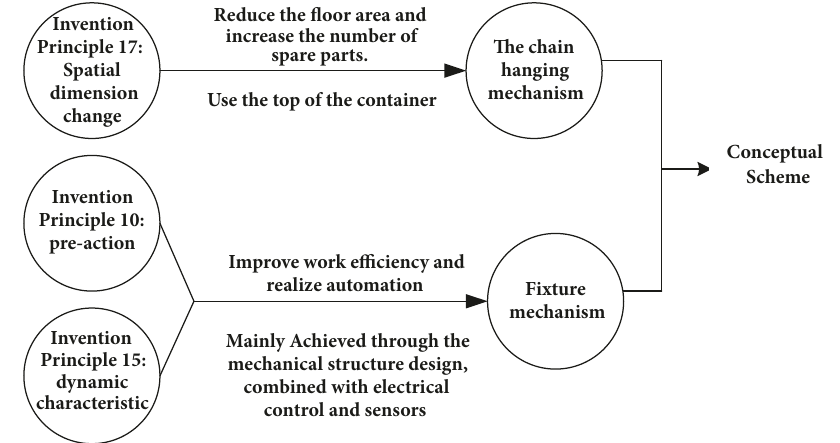
Figure 4: Concept scheme generation